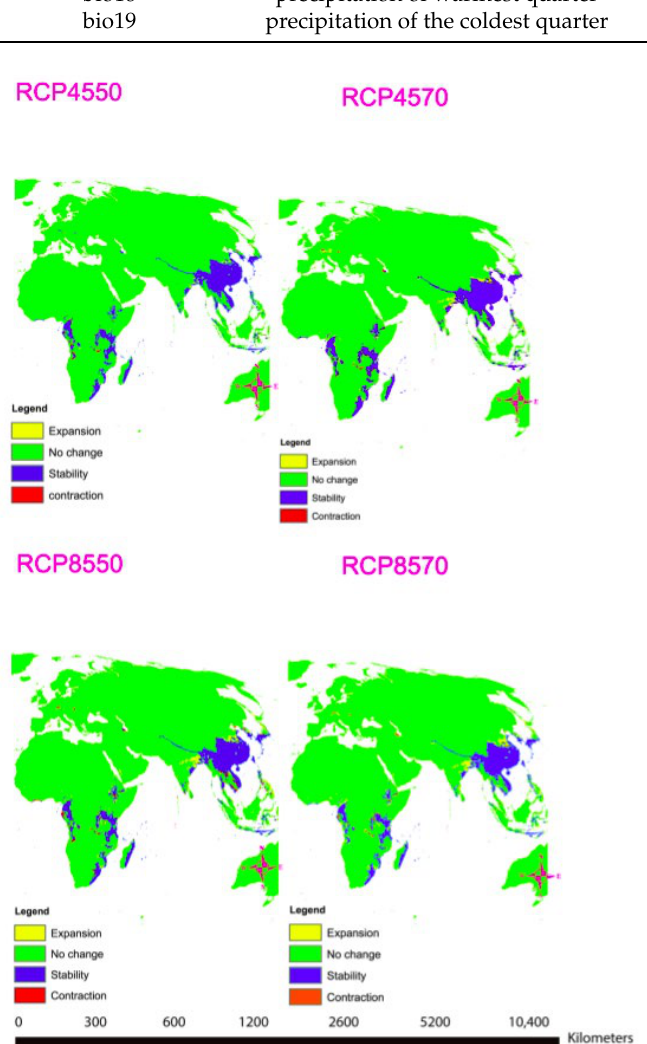
Figure 12. Maps showing distribution modeling for Toddalia asiatica for the years 2050 and 2070.